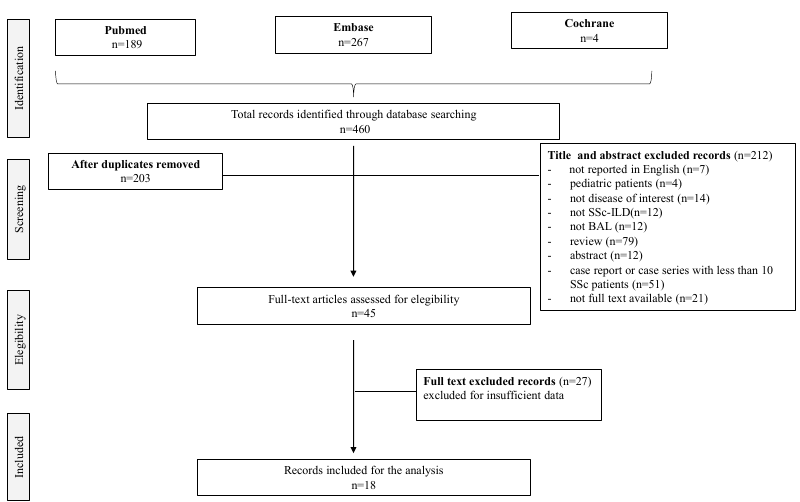
Figure 1. PRISMA flow chart. Flow chart describing the study inclusion and exclusion process.